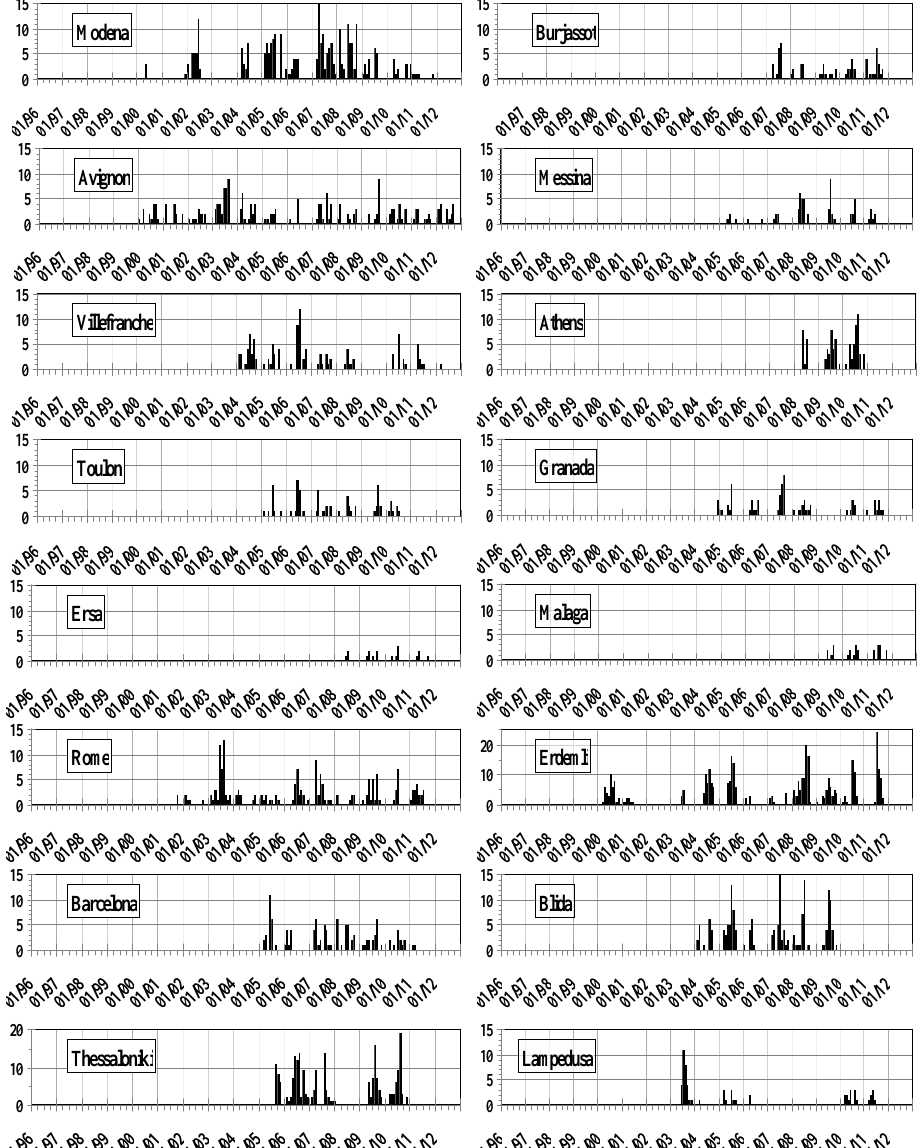
Fig. 4. Number of days with available level-2 AAOD (at 440 or 441nm) data at every AERONET station and for each month from January 1996 to December 2012. Note that Thessaloniki and Erdemli have vertical scales different from other